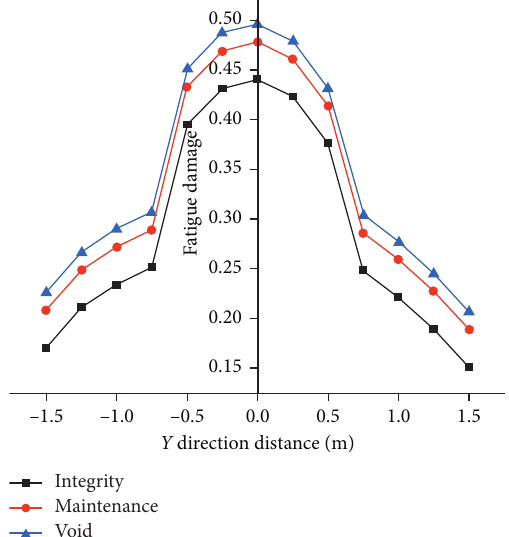
Figure 18: Fatigue damage distribution in Y direction at bottom of base under three conditions.